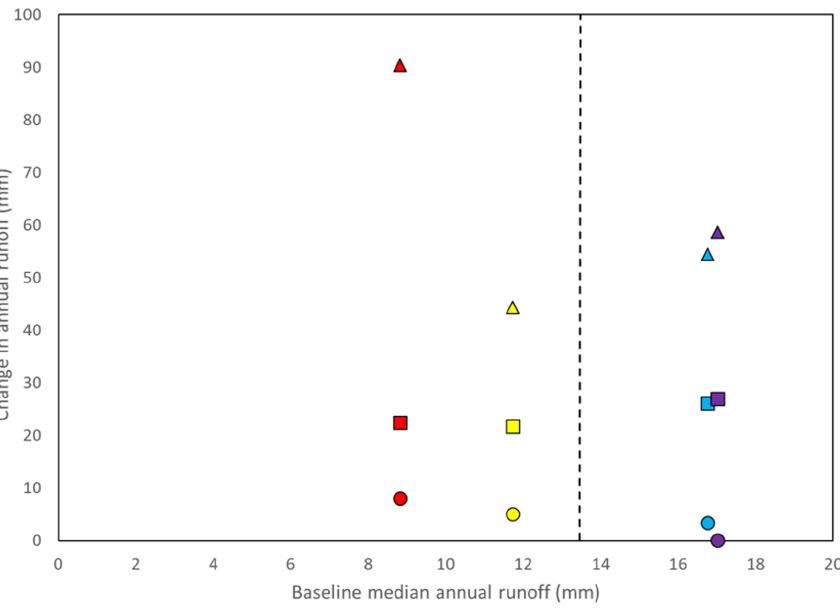
Figure 7. Change in mean minimum (circles), median (squares), and maximum (triangles) annual runoff for each of the four climate locations (red – North Battleford; yellow – Estevan; blue – Brandon; purple – Yorkton) compared to the baseline mean annual runoff. The dashed line represent 13.5mma − 1 of median runoff, which is the average of the four